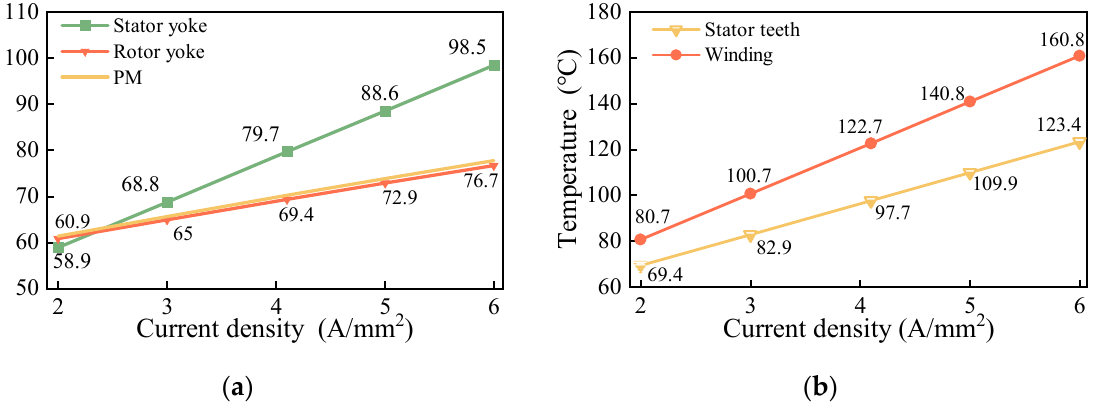
Figure 13. Temperature comparisons under different current densities: ( a ) temperature comparisons of rotor yoke, stator yoke, and PM; ( b ) temperature comparisons of stator teeth and winding.